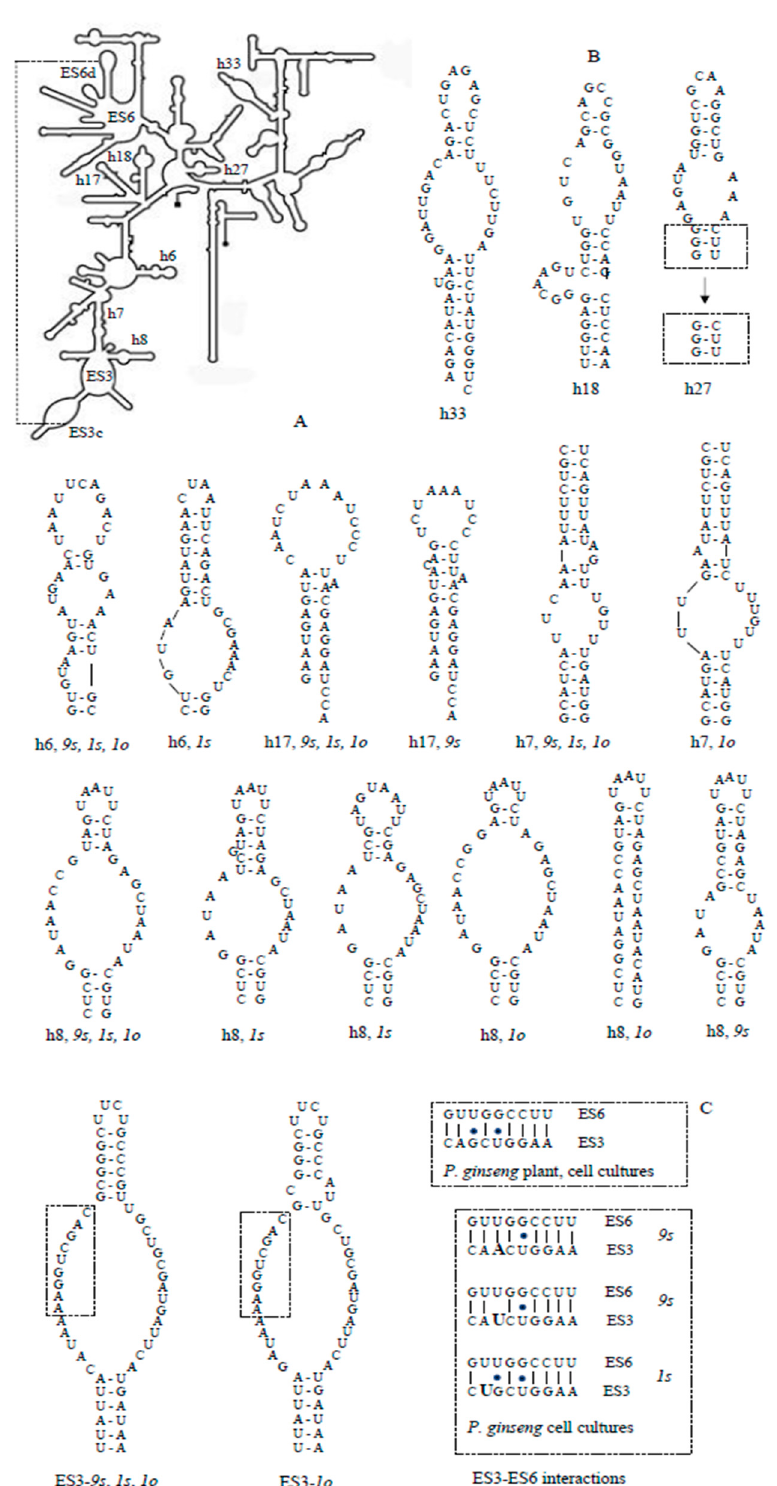
Figure 4. MFOLD prediction of the secondary structures for eight 18S rRNA regions of the Panax ginseng cell cultures. ( A ) Diagram of the secondary structure of wheat Triticum aestivum 18S rRNA (Armache et al., 2010) showing the model in this study region. The dotted line indicates the sites of interaction between ES3 and ES6; ( B ) The secondary structures of hairpins; ( C ) The secondary structures of expansion segment ES3b-c with sequences of the ES3–ES6 interaction sites.